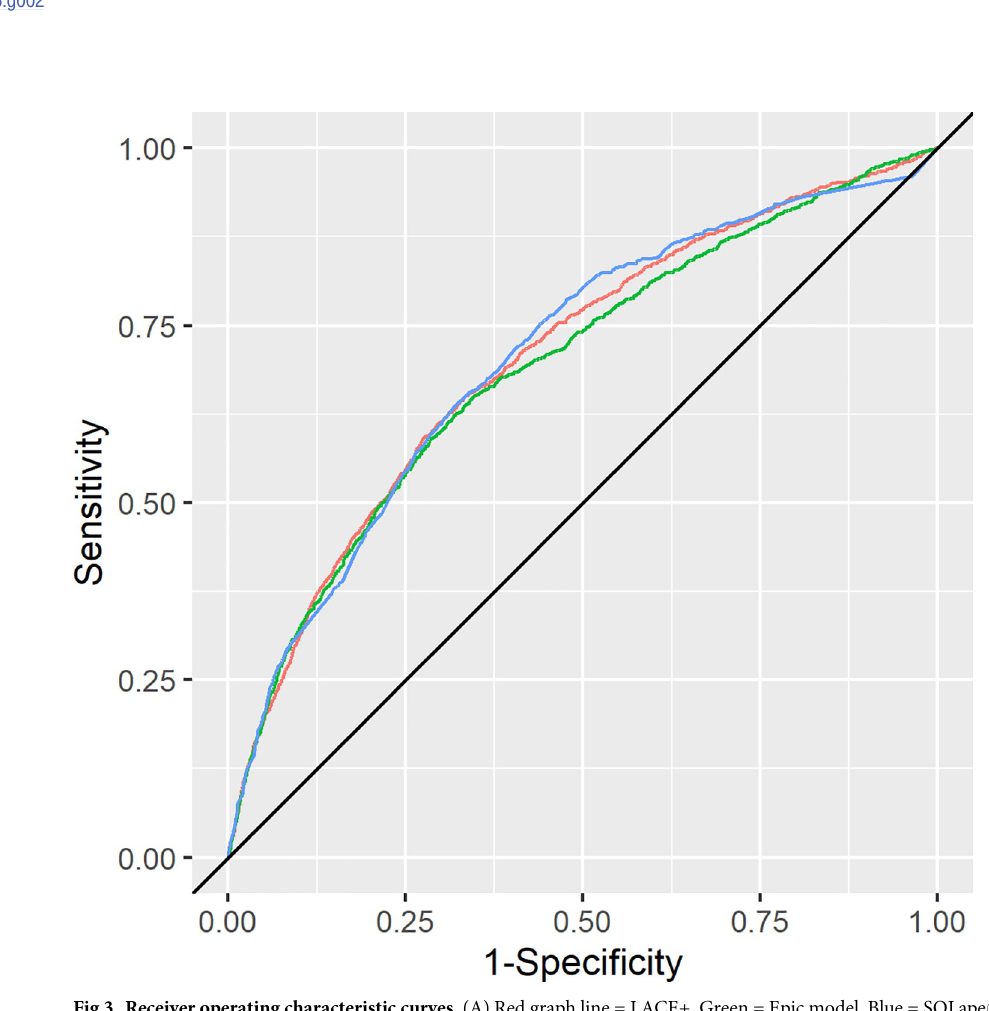
PLOS ONE | https://doi.org/10.1371/journal.pone.0258338 November12, 2021 24 /